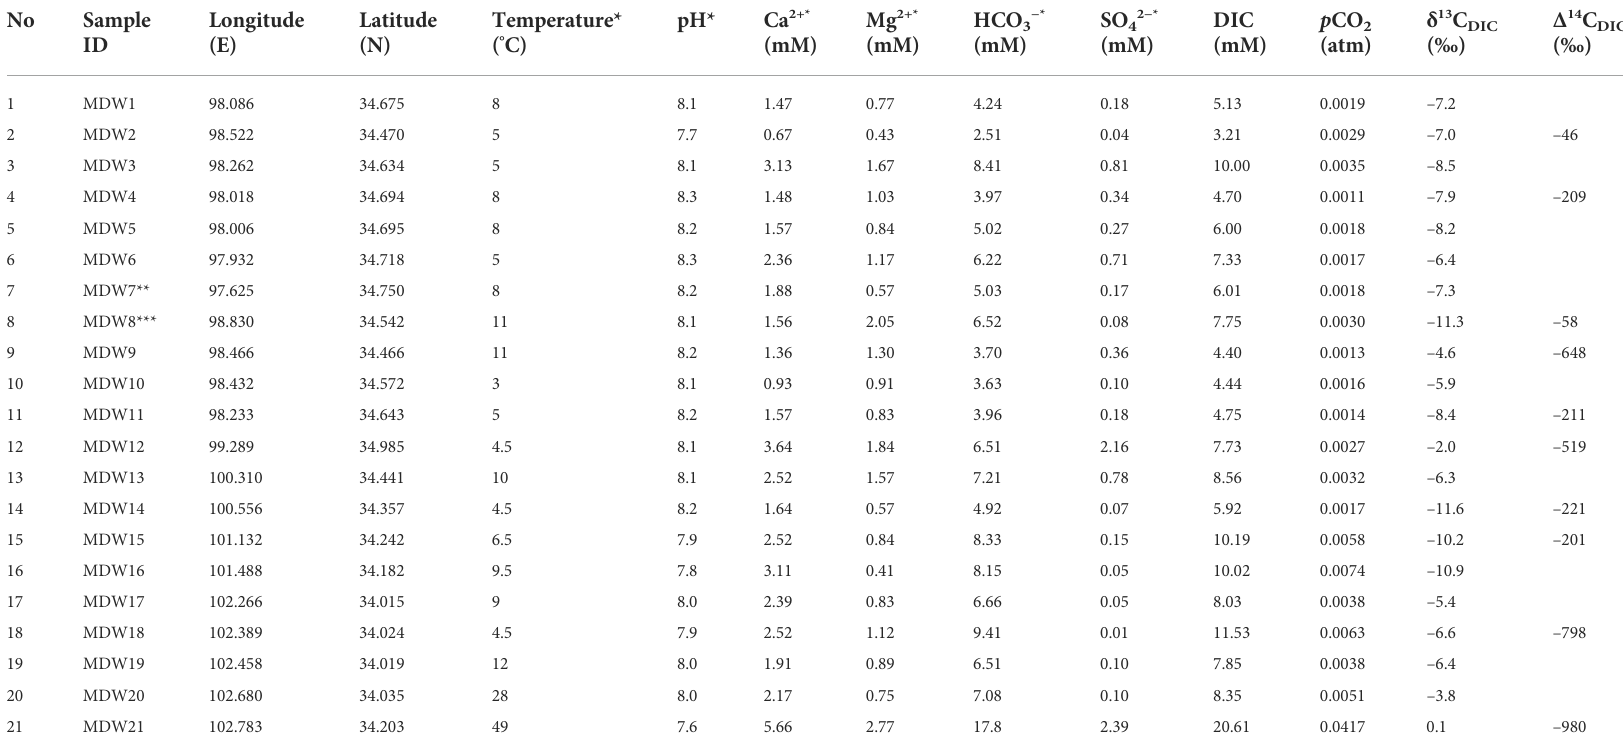
TABLE 1 Sample information, concentrations of major cations and anions, stable carbon isotopes and radiocarbon isotopes of the water